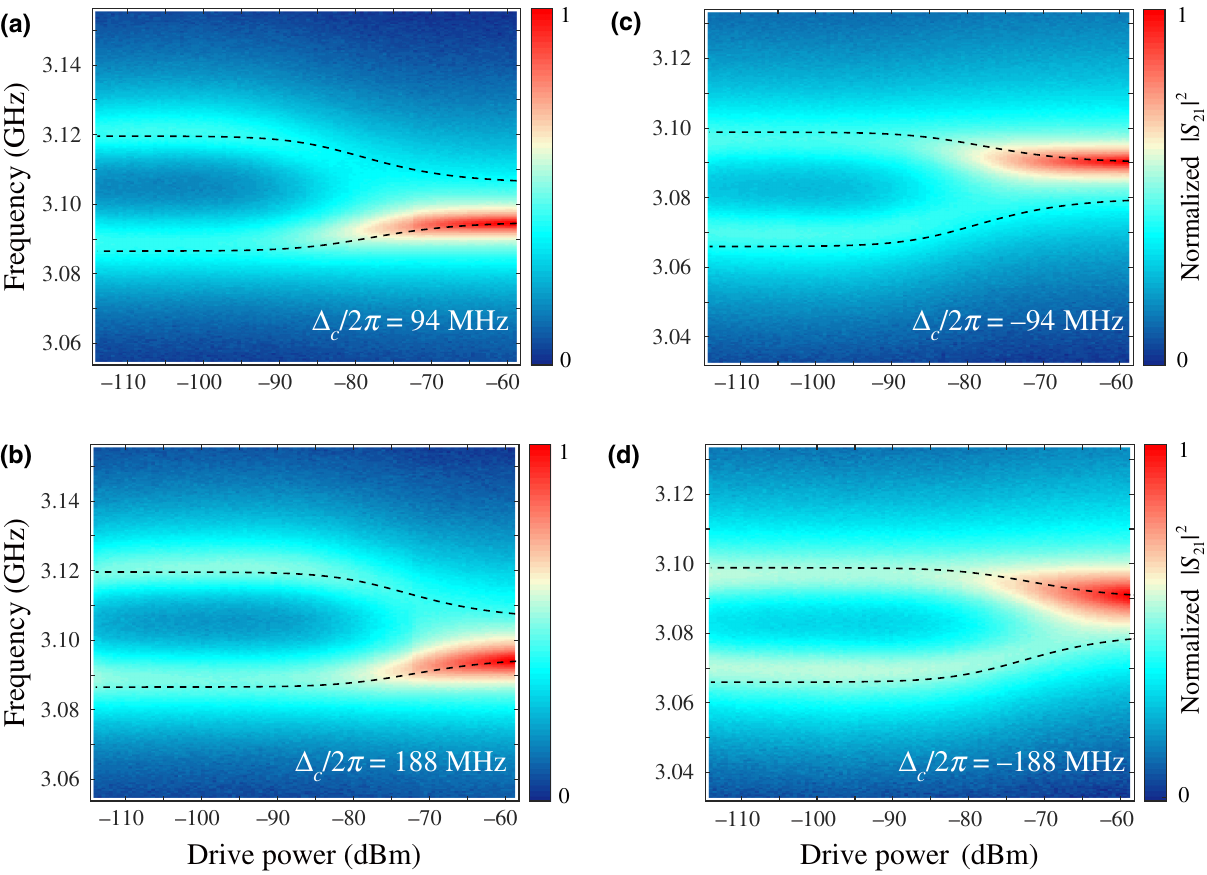
FIG. 10. The transmission spectra without the EP. (a),(b) The Rabi splittings related to the s = + subensemble, where the drive tone is in resonance with the s = 0 and s = − subensembles, respectively. (c),(d) The Rabi splittings related to the s = − subensemble, where the drive tone is in resonance with the s = 0 and s = + subensembles, respectively. The dashed curves are simulated as the real parts of the two eigenvalues, as in Figs. 4(c) and